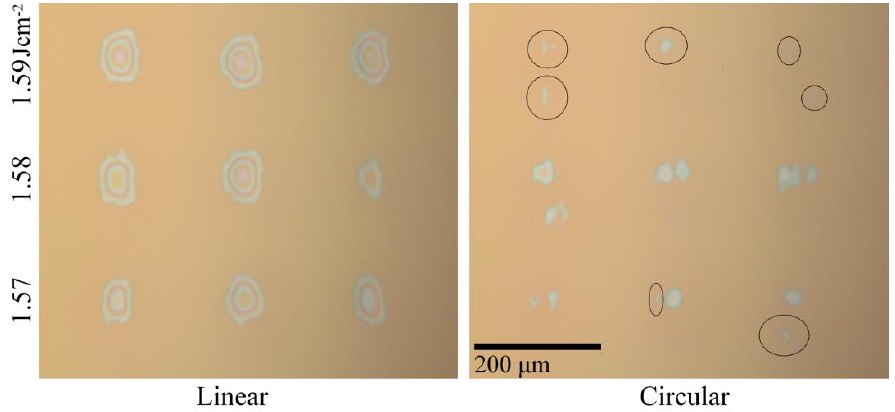
Figure 6. Damage morphology near damage threshold for linearly and circularly polarized lasers under 5-on-1. Note: black circle indicates some unapparent damage.